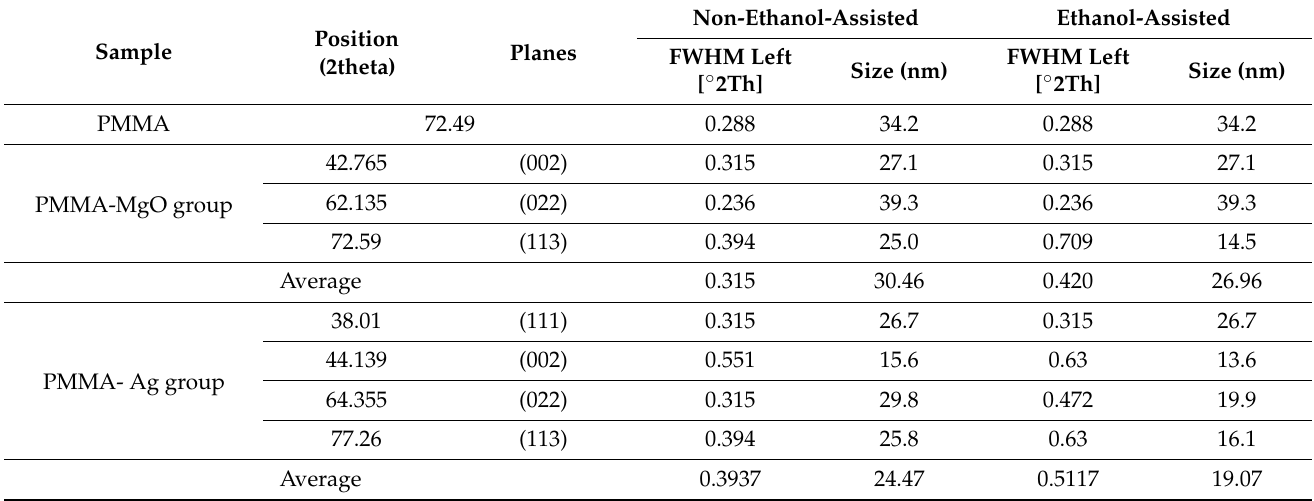
Table 1. Crystallite size of PMMA nanocomposite powders of Ag and MgO after non-ethanol-assisted mixing and ethanol-assisted mixing (sample number = 5 per each